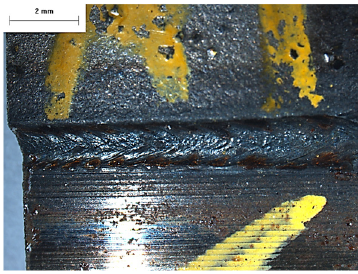
Figure 4. Image of the welded seam of the untreated sample.